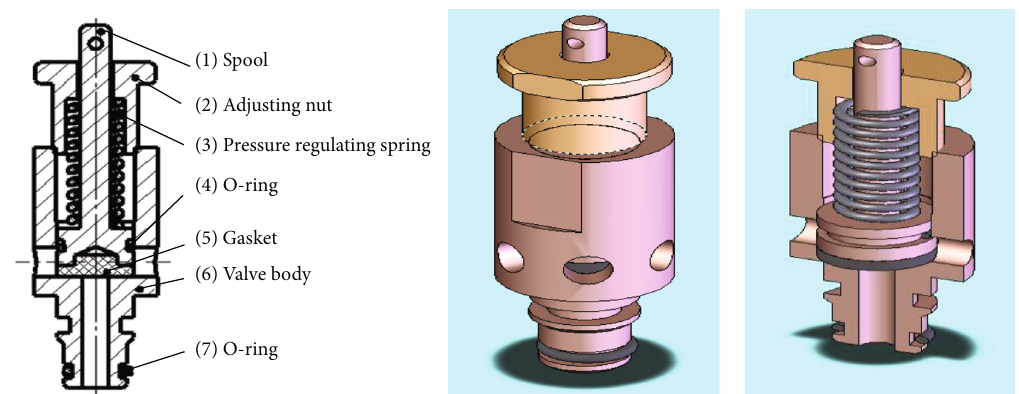
Figure 6: Schematic diagram of the structure of the safety pressure limiting valve.